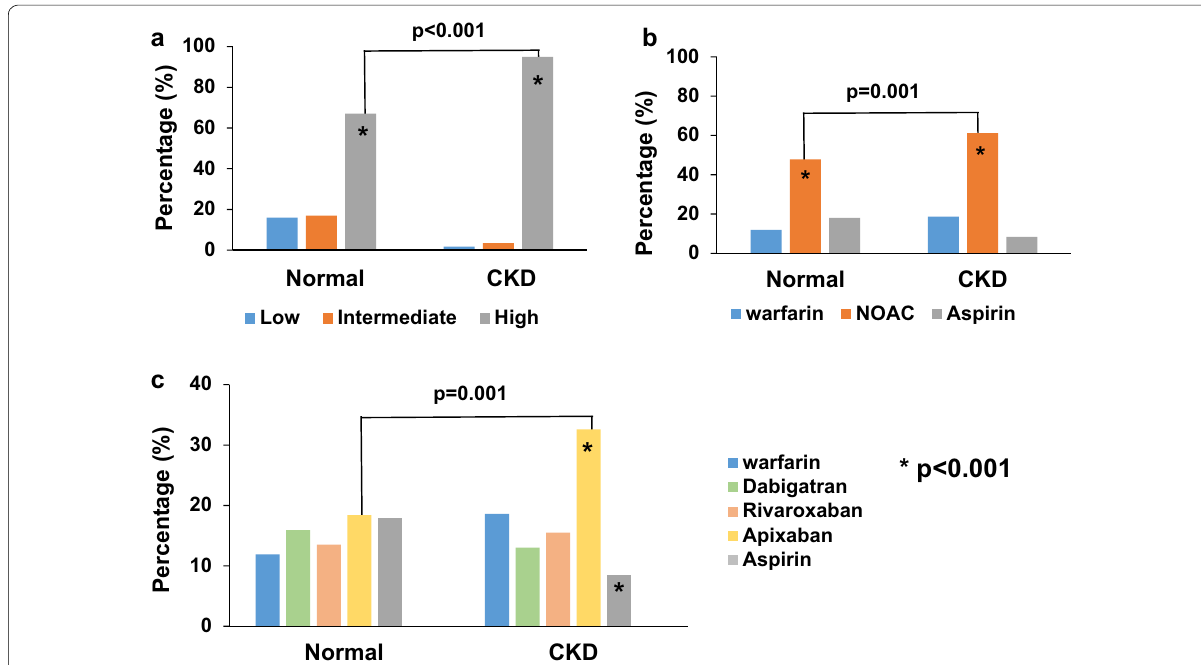
Fig. 2 Stroke risk and stroke prevention in atrial fibrillation patients with CKD. a Comparison of stroke risk in each group. The proportion of high stroke risk was higher in the CKD group than in the normal group (94.9% vs. 67.0%, p < 0.001). b Comparison of oral anticoagulant medication in each group. The CKD group had a higher usage rate of NOAC than the normal group (61.1% vs. 47.8%, p group. Among NOACs, apixaban was most frequently used in CKD patients compared with controls (32.6% vs. 18.4, p